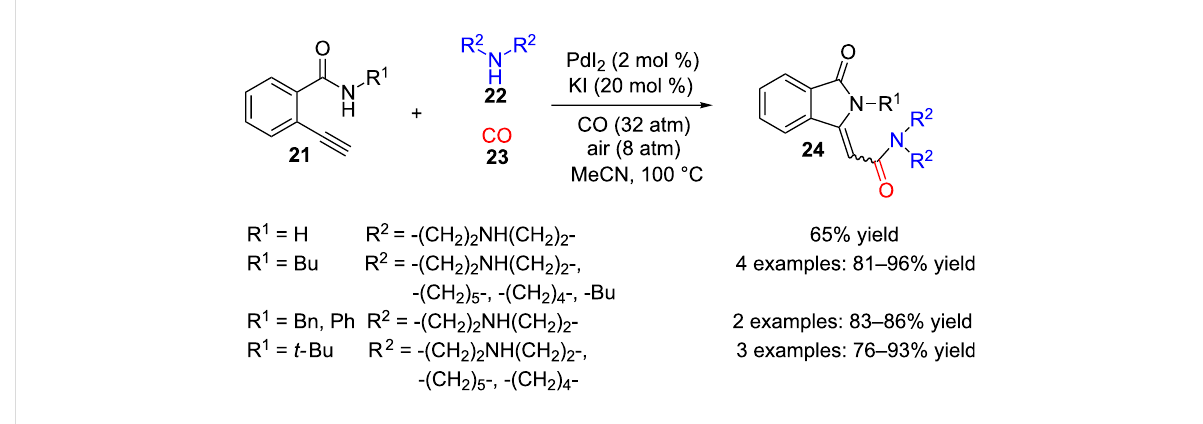
Scheme 5: Palladium-catalysed three-component reaction of ethynylbenzamides 21 , secondary amines 22 and CO ( 23 ).